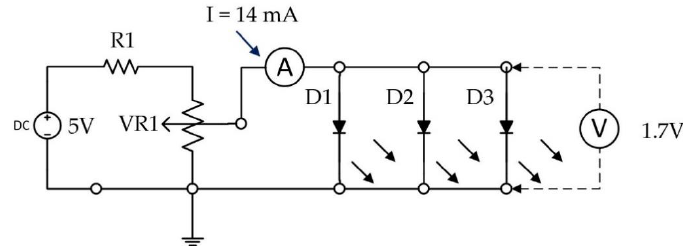
Figure 4. Schematic diagram of the illumination circuit.